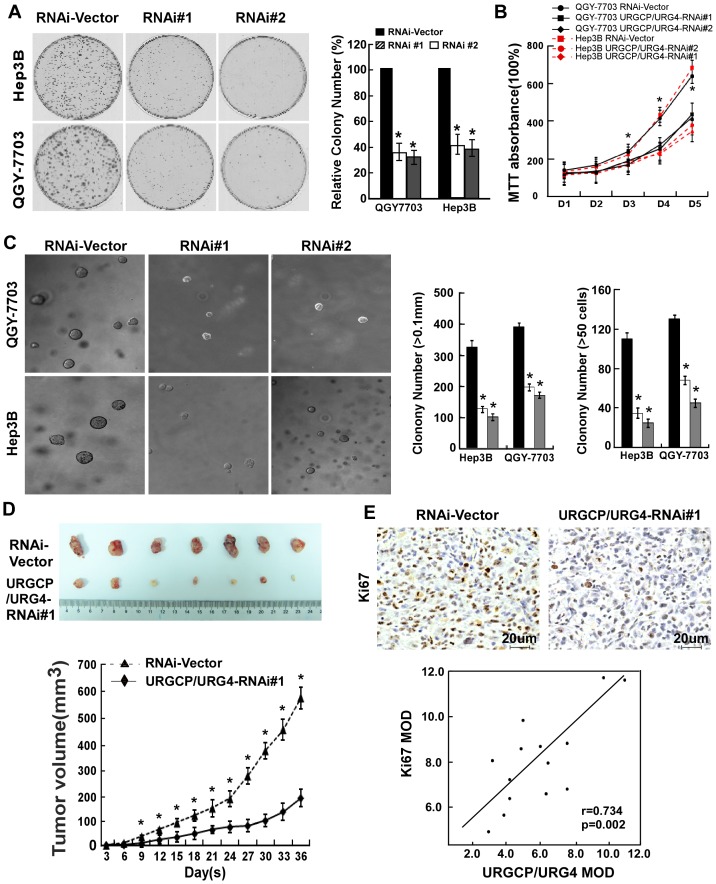
URGCP/URG4 is essential for HCC cell proliferation.Representative micrographs (left panel) and quantification (right panel) of crystal violet-stained cells (A). Silencing endogenous URGCP/URG4 inhibited cell growth, as determined by MTT assay (B). Silencing endogenous URGCP inhibited cell growth, as determined by anchorage-independent growth assay (C). Soft agar colony formation by indicated cells after 10 days of culture (left panel); colonies larger than 0.1 mm in diameter (middle panel) or those contained more than 50 cells/colony (right panel) were scored. Each bar represents the mean ± SD of three independent experiments. Xenograft model in NOD/SCID mice (D). QGY-7703/vector cells and QGY-7703/URGCP/URG4 RNAi#1 cells were injected into the groin of athymic mice and excised at experimental endpoint (upper panel). Tumor volumes were measured on the indicated days. Representative graph of tumor growth and mean tumor weights 5 weeks after inoculation are shown (lower panel). All data are shown as mean ± SD. IHC staining of URGCP/URG4 and Ki-67 in mouse HCC specimens (E). IHC analyses were performed for two independent times on each of the samples (upper panel); a significant correlation between URGCP/URG4 and Ki-67 levels was observed (r = 0.734; P<0.005; lower panel).